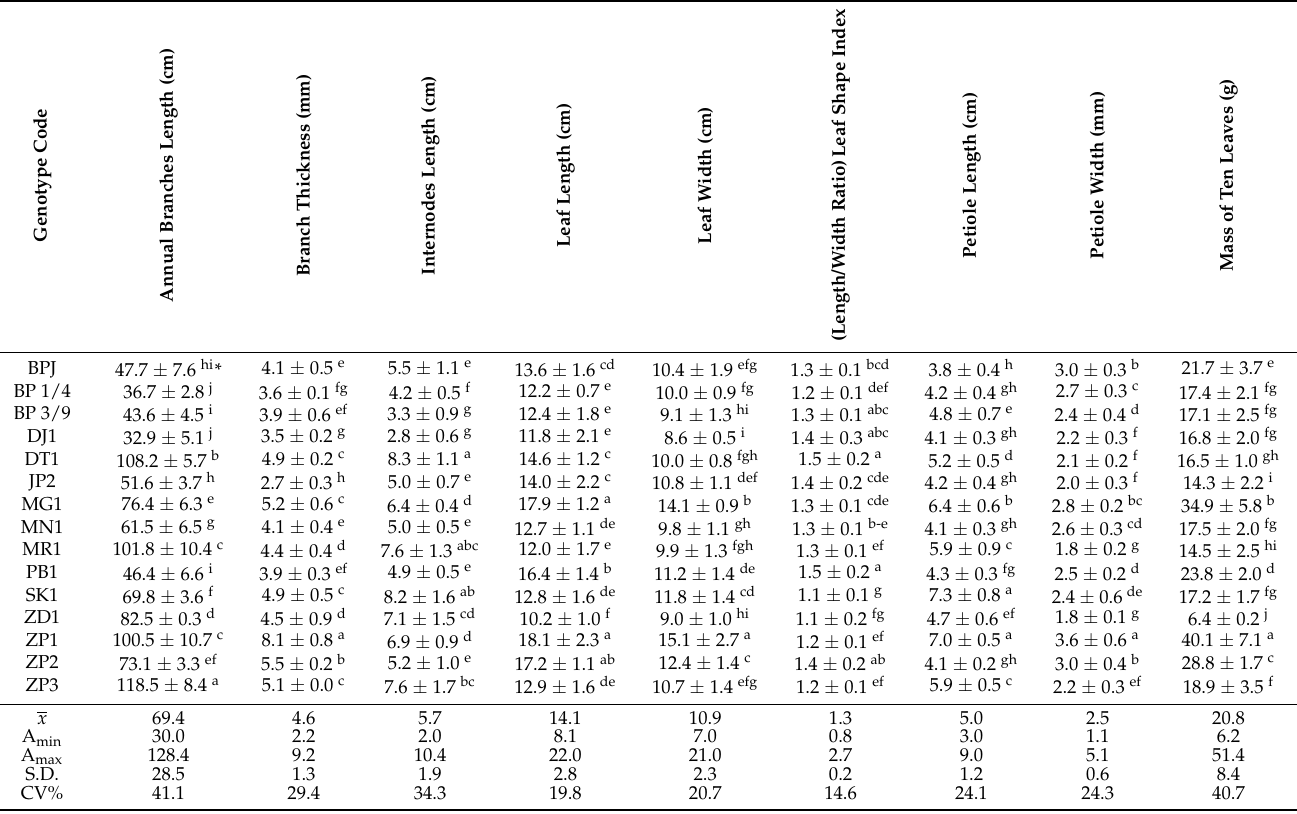
(11.8 cm) and PB1 (11.2 cm). Mean averages for leaf length and leaf width amounted to 14.1 and 10.9 cm (respectively), with an absolute maximum of 22.0 and 21.0 cm for leaf length and leaf width determined in genotype ZP1. Table 3. Morphometric characteristics of branches and leaves sampled from studied